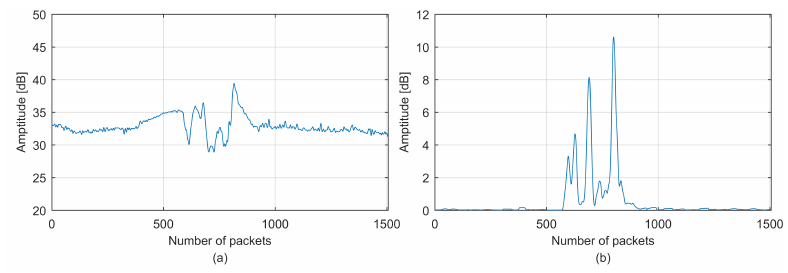
Figure 6. MVS segmentation: ( a ) the fused CSI stream; ( b ) corresponding moving variance